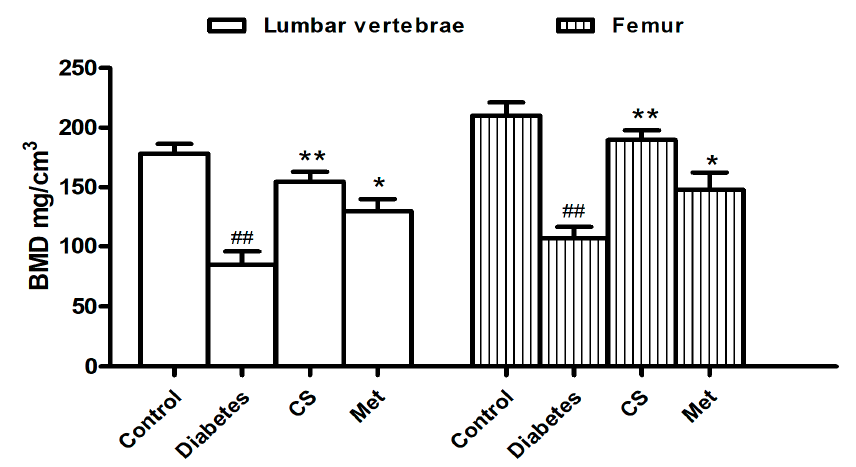
Figure 2. Lumbar vertebrae and femur bone-mineral density (BMD) of each group at the end day of the animal experiment. ## p < 0.01 compared with the control group; ** p < 0.01 compared with the diabetic group, * p < 0.05 compared with the diabetic group.